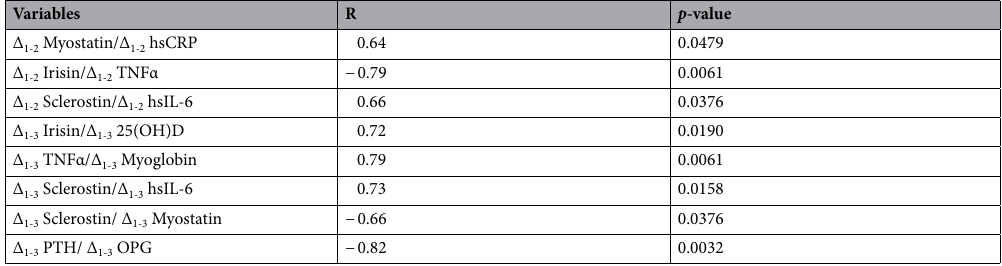
Table 1. Spearman’s rank correlation coefficients of tested variables. 1 = before marathon race, 2 = 24 h after marathon race, 3 = 72 h after marathon